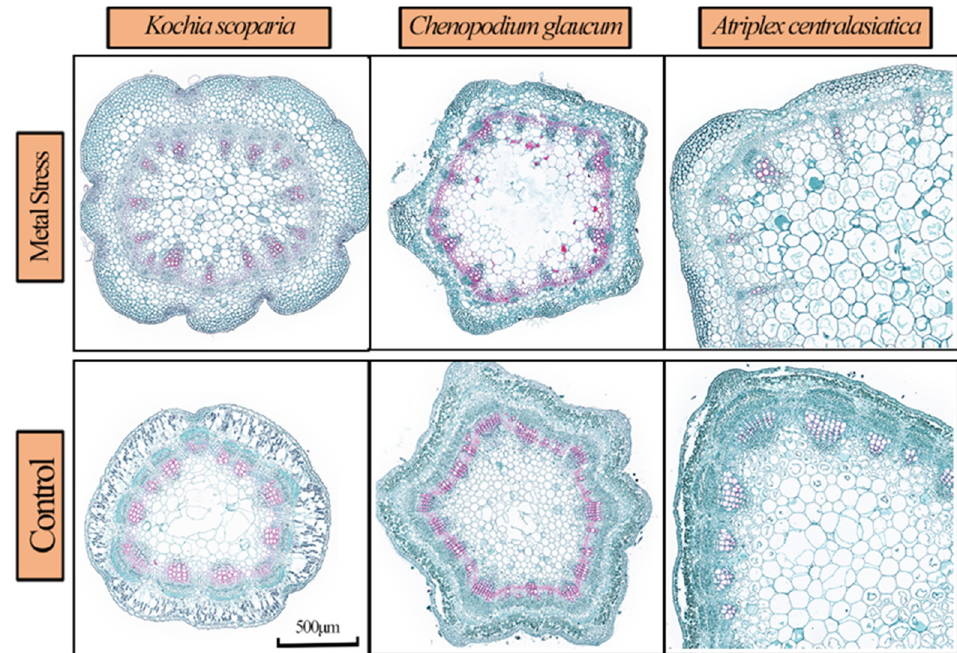
Figure 6. Stem cross-sections of three plants under native soil and tailings stress conditions.